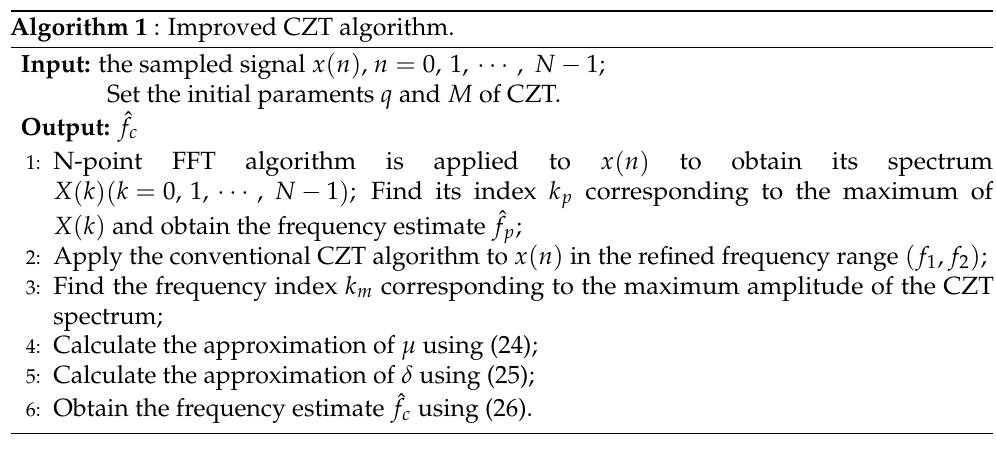
Table 1. The computational complexity of various